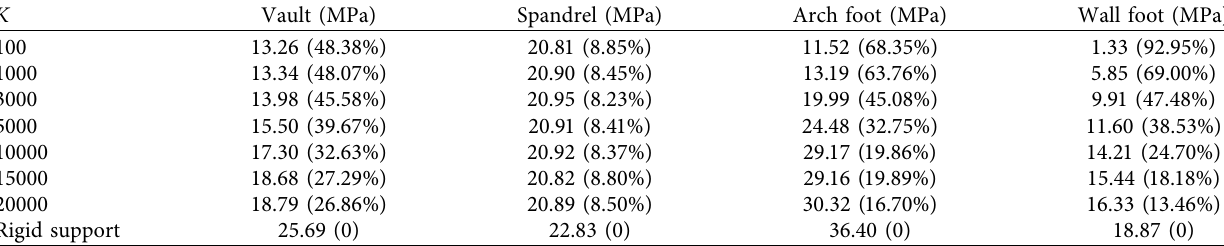
Table 8: Peak equivalent stress values at the study